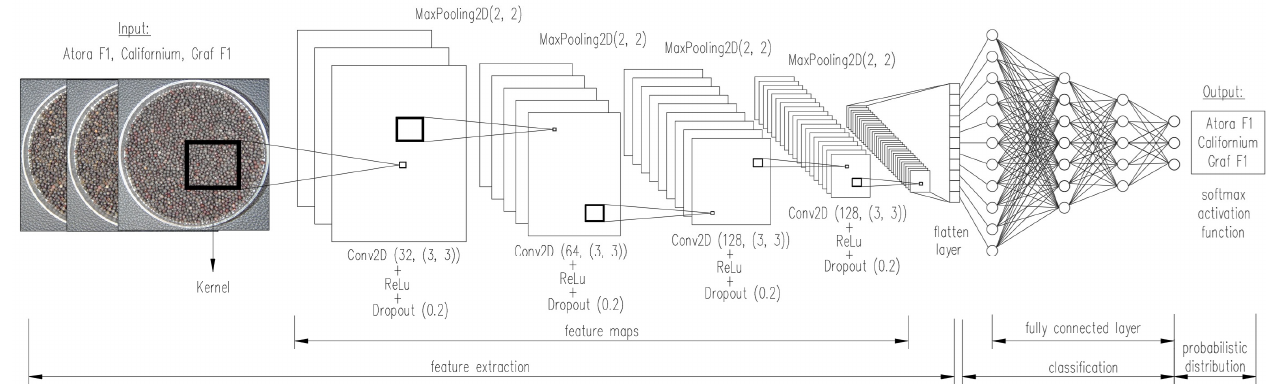
Figure 3. Diagram of the implemented CNN network.